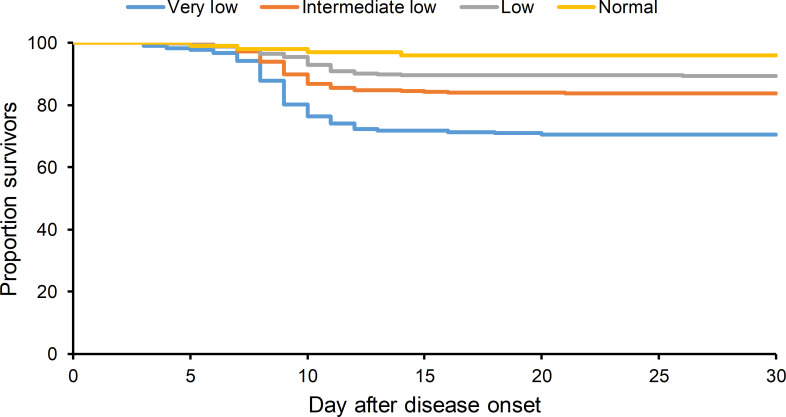
Kaplan-Meier survival curves of SFTS patients with different PLT counts.The patients were classified into four groups according to the lowest PLT counts within first 7 days after disease onset: Very Low indicates PLT count ≤30×109/L, Intermediate low indicates PLT count 30×109/L~50×109/L, LP indicates PLT count 50×109/L~100×109/L, NP indicates PLT >100×109/L.